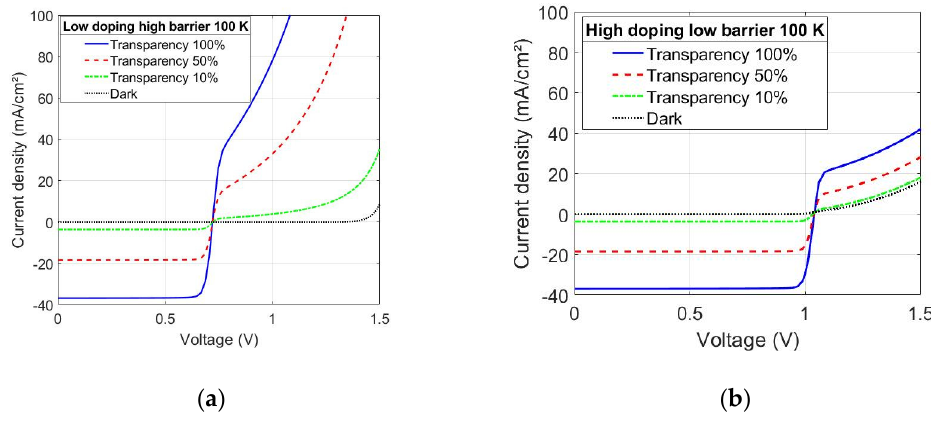
Figure10. SimulatedI–Vcurvesat100Kfor( a )thelow-dopinghigh-barriercaseand( b )thehigh-doping Figure 10. Simulated I–V curves at 100 K for ( a ) the low-doping high-barrier case and ( b ) the high- low-barrier case with an absorber thickness of 1.5 µ m with 100%, 50% and 10% transparency. doping low-barrier case with an absorber thickness of 1.5 µm with 100%, 50% and 10% transparency.